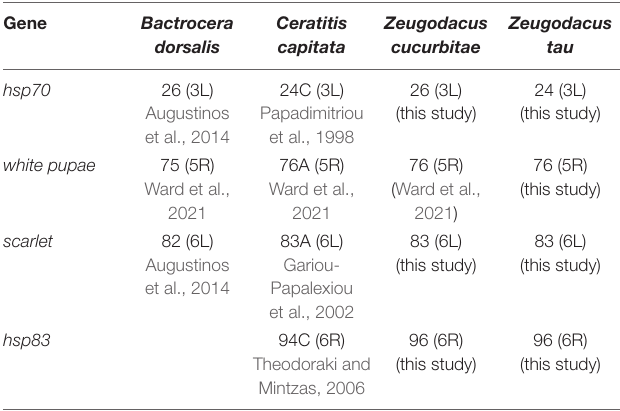
TABLE 1 | Localization of gene markers on the polytene chromosomes of Bactrocera dorsalis , Ceratitis capitata , Zeugodacus cucurbitae , and Zeugodacus tau